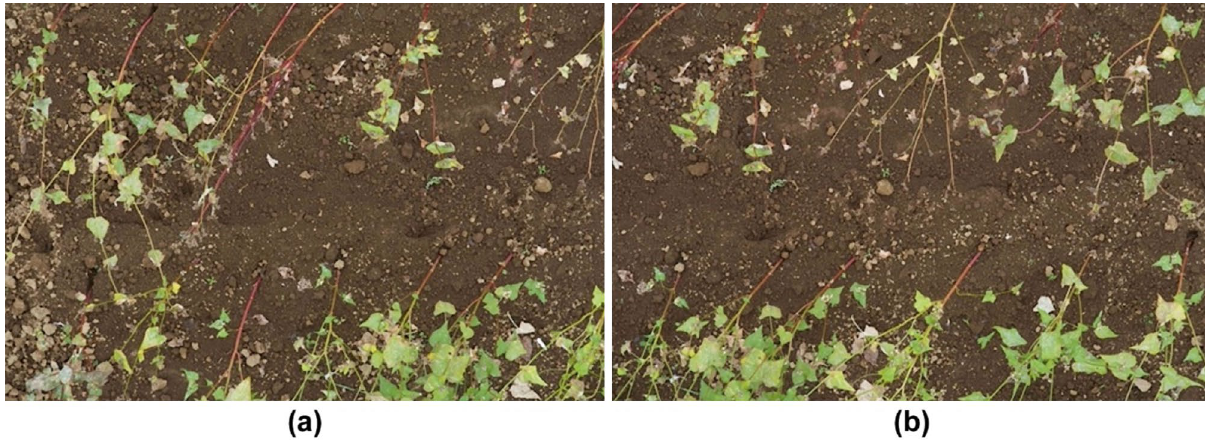
Figure 15. Two images with longer baseline lengths than those shown in Fig.